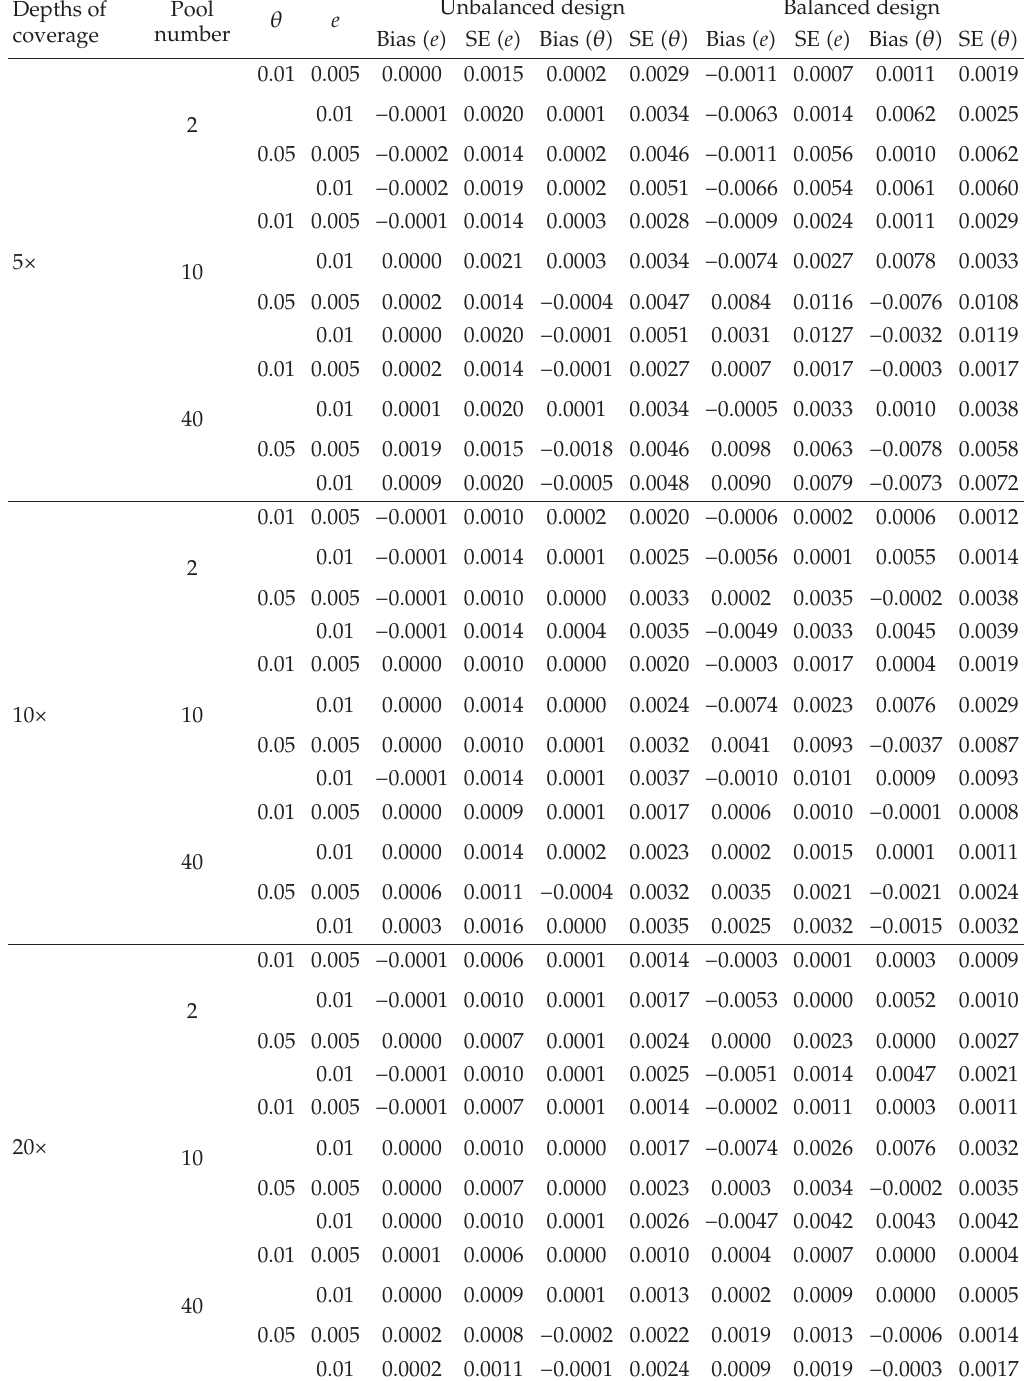
Table 1: Estimated bias and standard error (cid:2) SE (cid:3) of the sequencing error rate and the allele frequency for the unbalanced and balanced designs under di ff erent sequencing depths of coverage, numbers of pools, allele frequencies, and sequencing error